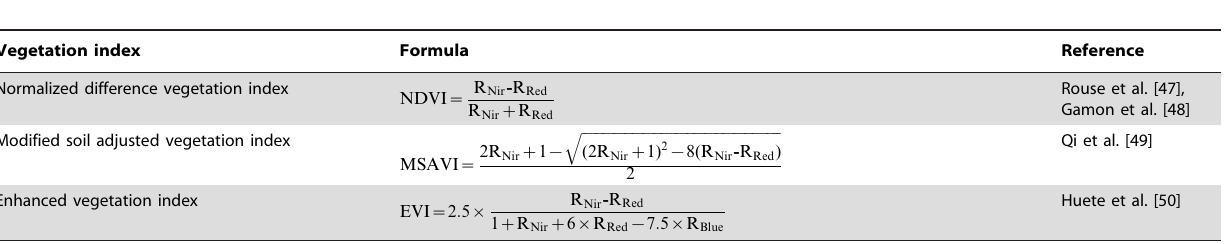
Table 1. Calculation for vegetation indices a